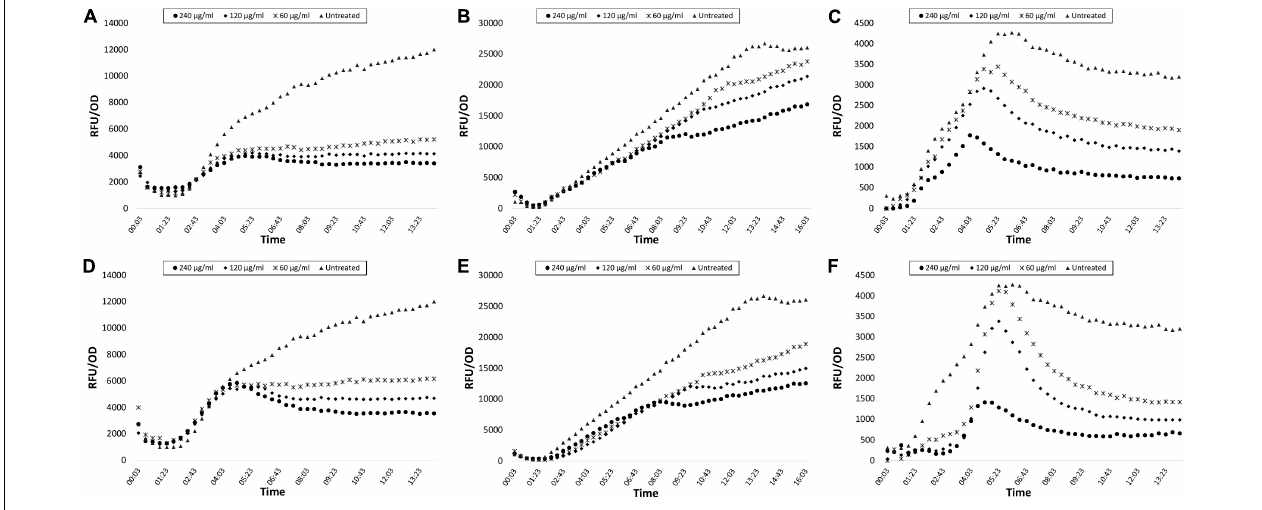
FIGURE 1 | GFP expression curves of lasB-gfp, rhlA-gfp , and pqsA-gfp monitor strains treated with CFSE and CE obtained from N. versiforme . Data are shown as Relative Fluorescence Unit over Optical Density of 450 nm. (A) lasB-gfp CFSE, (B) rhlA-gfp CFSE, (C) pqsA-gfp CFSE, (D) lasB-gfp CE, (E) rhlA-gfp CE, (F) pqsA-gfp